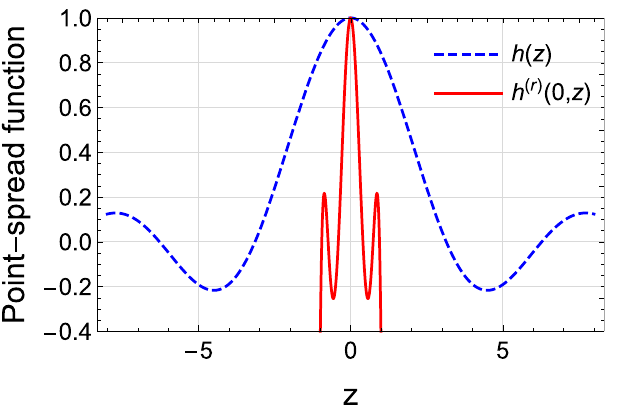
Figure 10. Point-spread function as a function of z . The blue-dashed line denotes the traditional optical imaging system and the red one indicates the super-resolving-Fourier-microscopy imaging